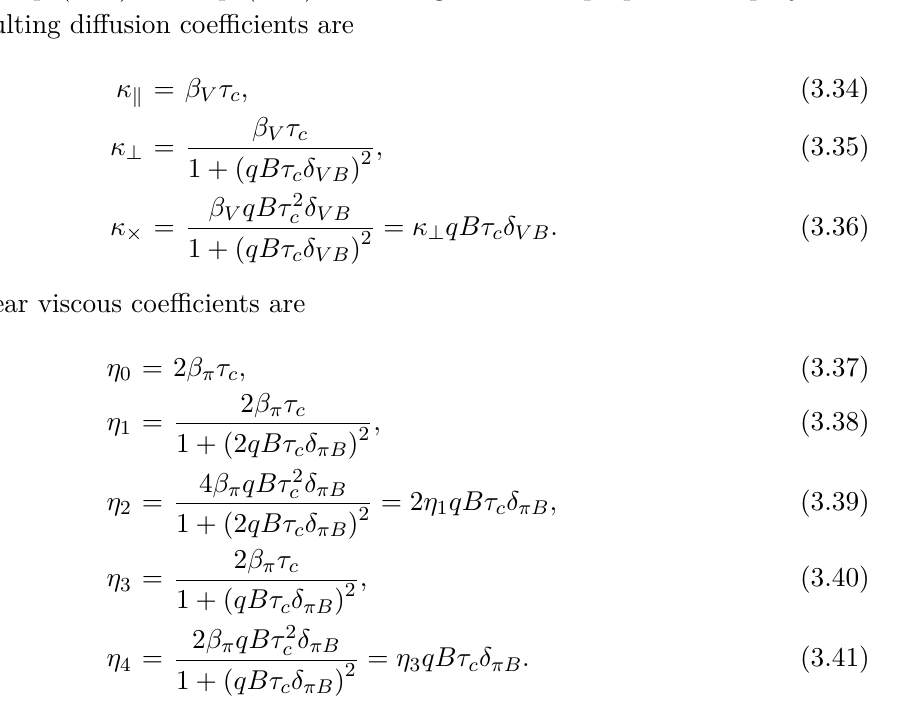
Figure 2 . The magnetic-field dependence of the diffusion coefficients and the shear-viscosity coef- ficients. The solid lines are the results from the current work while the dotted lines are from ref. [1]. left hand side of eq. (3.31) and eq. (3.30) and using the usual properties of